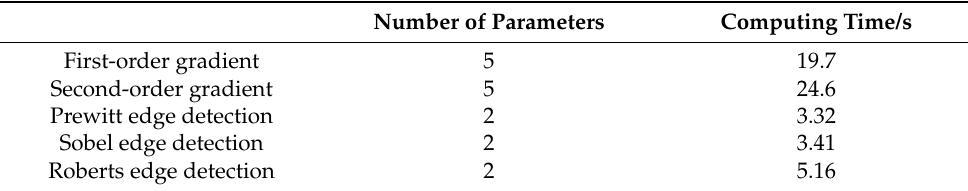
Table 4. Comparison of two post-processing algorithms.